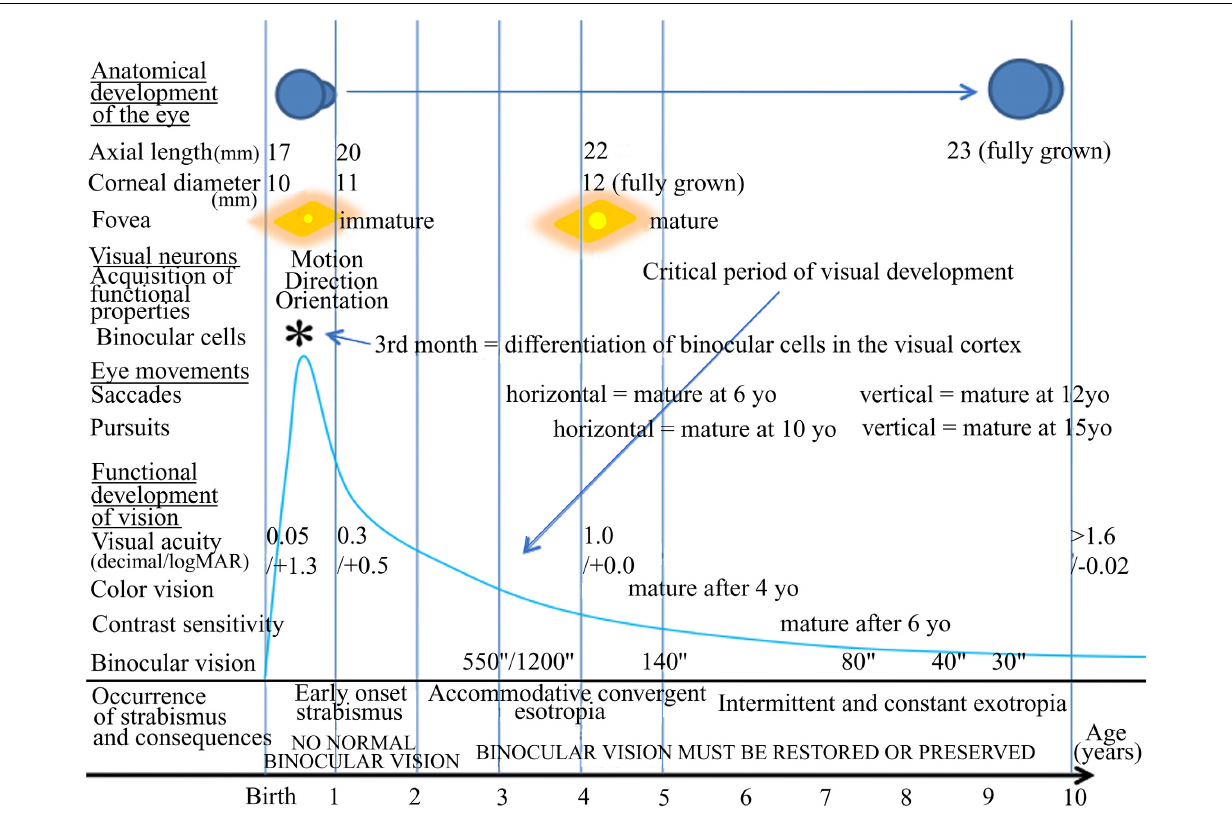
becoming “binocular.” Eye movements such as saccades and pursuits also become “adult-like” with age but not at the same age. Altogether, this leads to the development of visual perception including acuity, color vision, contrast sensitivity, binocular vision and 3D perception. All of these processes occur during the so-called “critical period” of development, which corresponds to a periodofhighplasticity.Thisplasticityhoweverchangeswithage,withitspeak during the first postnatal year (as illustrated by the blue drawing). In case of abnormalvision,suchasstrabismus,duringthisperiod,thedevelopmentofthe visualsystemandofvisualperceptionitselfmaybegreatlyaltered,inparticular regarding the development of an amblyopia and the loss of binocular vision. yo: years old. ∗ , 3rd month: differentiation of binocular cells in the visual